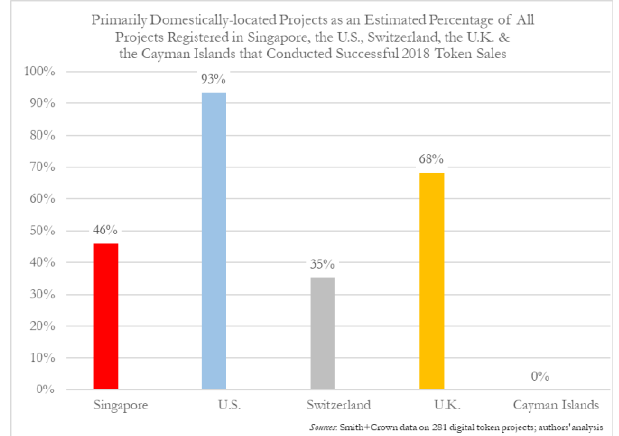
Figure 5: Almost half of projects that conducted successful 2018 Singapore-registered token offerings were primarily physically-located in the